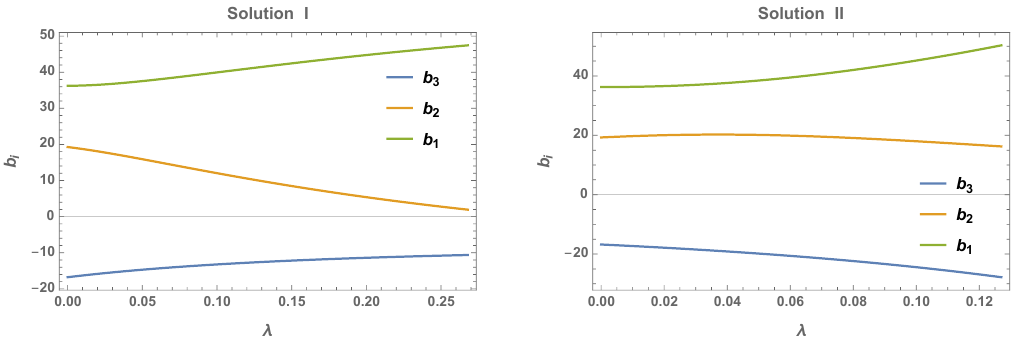
Figure 4 . The eigenvalues b i as a function of λ . The left plot corresponds to the solution I and the right to the solution II. The existence of the negative eigenvalue b 3 in both cases suggests that the AdS 6 solutions I and II are